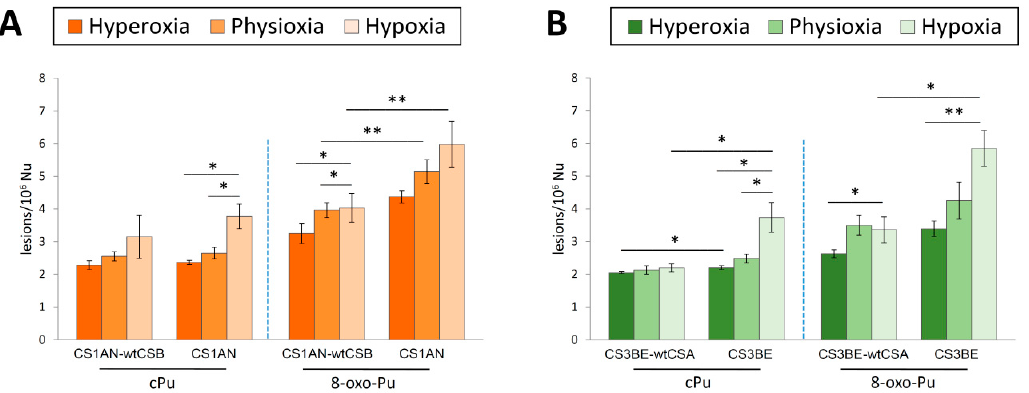
Figure 2. Comparison between cPu and 8-oxo-Pu lesions under hyperoxia, physioxia and hypoxia. ( A ) The levels (lesions / 10 6 Nu) of cPu and 8-oxo-Pu lesions in genomic DNA extracted from CS1AN-wtCSB and CS1AN cells. ( B ) The levels (lesions / 10 6 Nu) of cPu and 8-oxo-Pu lesions in genomic DNA extracted from CS3BE-wtCSA and CS3BE cells. The error bars represent the standard deviation of the mean, calculated from three independent samples, * denotes a statistically significant di ff erence ( p < 0.05) between the groups, ** denotes a statistically significant di ff erence ( p < 0.01) between the